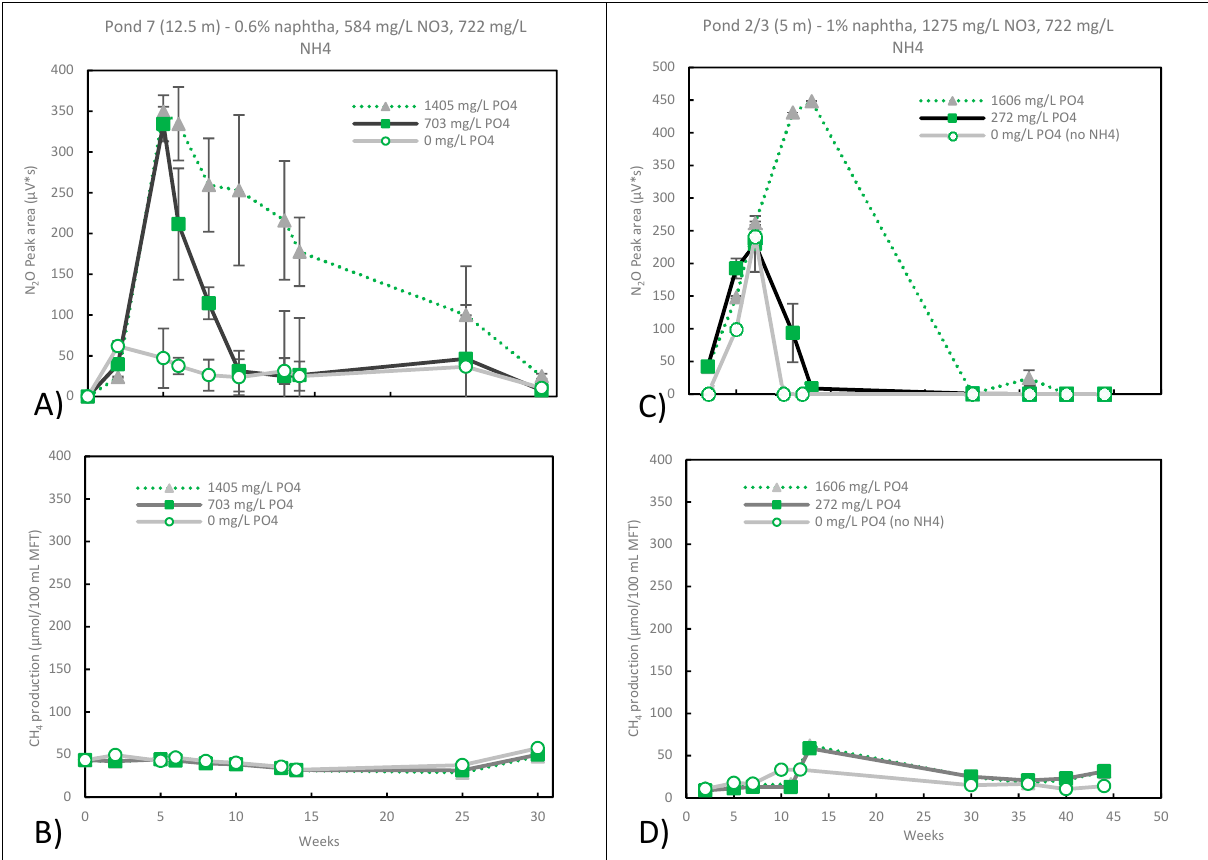
Figure 4. The effect of NH 4+ and PO 43- on ( A ) N 2 O and ( B ) CH 4 production by Pond 7 (12.5 m) MFT and ( C ) N 2 O and ( D ) CH 4 production by Pond 2/3 (5 m) under nitrate-reducing conditions. Measured nitrate concentrations in the pore waters of Pond 7 at week 0 were ~645 mg/L, which decreased to below detectable levels by week 34. For Pond 2/3 (5 m) at week 0, they were ~1400 mg/L, decreasing to ~24 mg/L by week 13 and were below detectable levels by week 44. Microcosms were setup in duplicate, error bars were inserted, and where not visible, the error was too small to be seen.